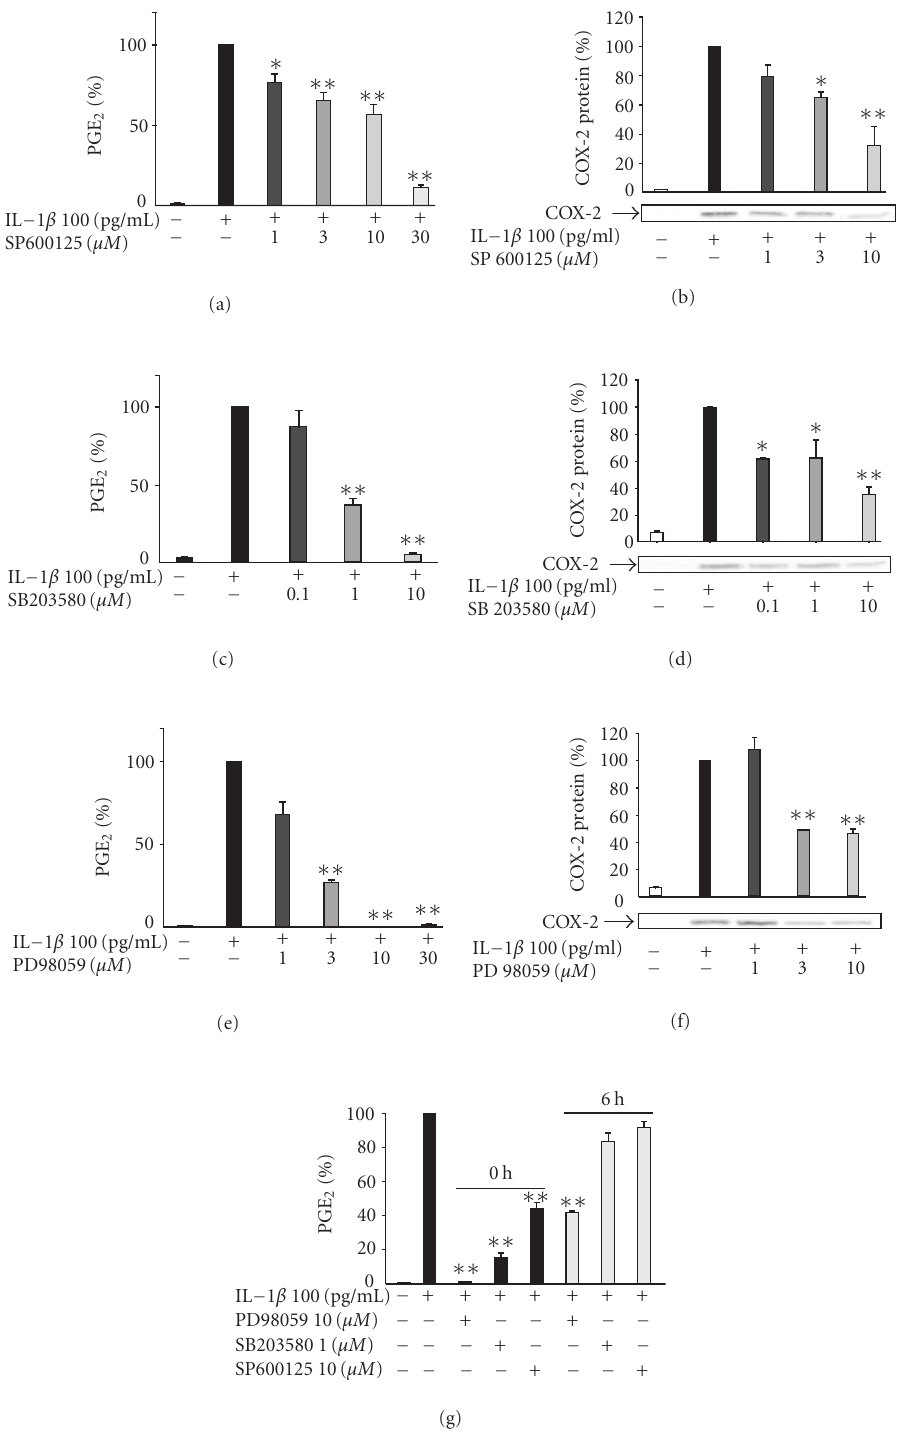
Figure 3. The e ff ects of SP600125, SB203580, and PD98059 on PGE 2 production and COX-2 protein expression in IL-1 β -stimulated human T/C28a2 chondrocytes. Human chondrocytes were incubated with IL-1 β (100pg/mL) and increasing concentrations of (a), (b) SP600125 (JNK inhibitor), (c), (d) SB203580 (p38 inhibitor), and (e), (f) PD98059 (Erk1/2 inhibitor). After 24 h, incubations were terminated, and PGE 2 concentrations in the culture medium were measured by RIA ((a), (c), (e)) and COX-2 protein was measured by Western blot ((b), (d), (f)). (g) SP600125 (10 µ M), SB203580 (1 µ M), and PD98059 (10 µ M) were added to the cell culture at the same time (0h) or 6h after IL-1 β (6h). After 24h, PGE 2 concentrations were measured in the culture medium by RIA. Mean ± SEM, n = 4, ∗∗ indicates P < . 01 as compared with the respective control. In (b), (d), and (f) a representative gel is shown under the